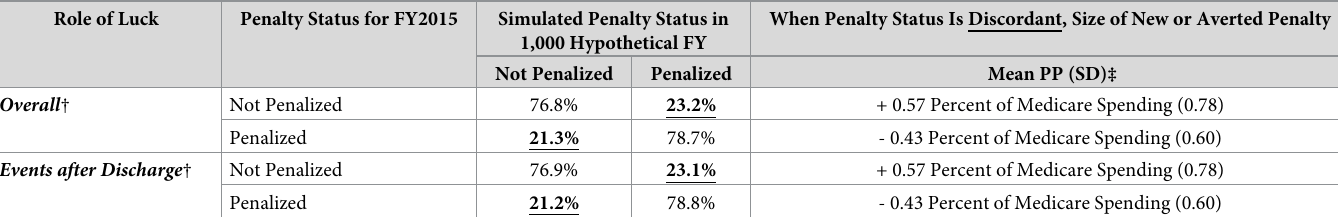
Table 2. Comparison of recreated HRRP penalty status for FY2015 � with simulated penalties for 1,000 hypothetical fiscal years.